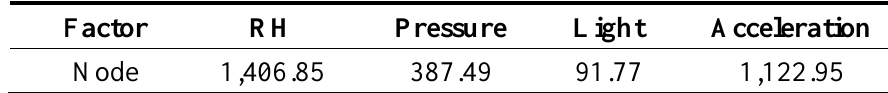
Table 3. ANOVA of RH, pressure, light and acceleration data. Fishers‟s F considering node location as a factor (confidence interval